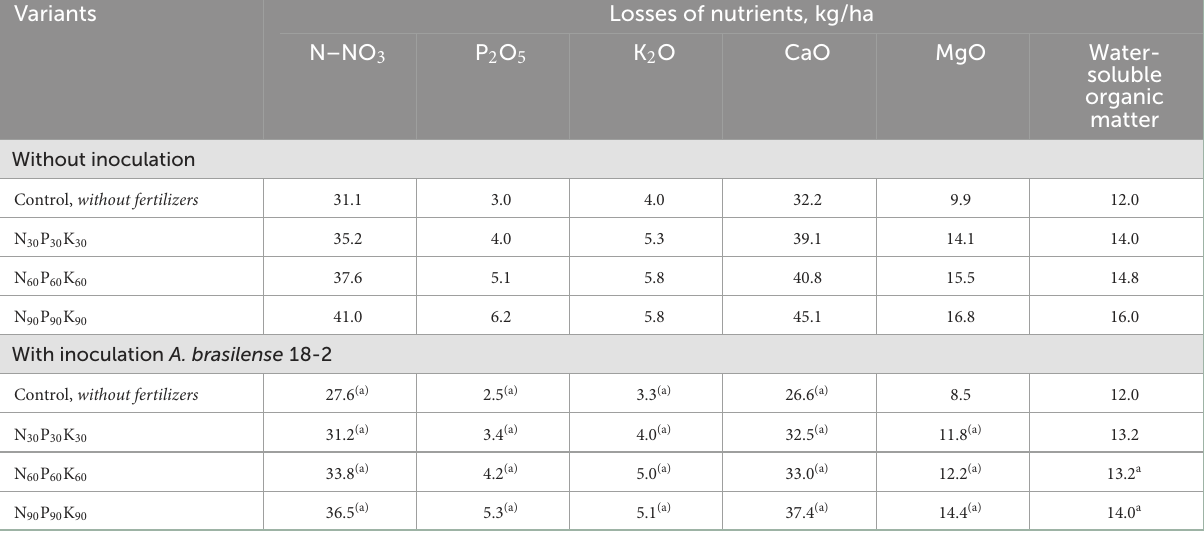
TABLE 6 The effect of fertilizers and pre-sowing winter rye seeds inoculation with A. brasilense 18-2 on losses of nutrients and water-soluble organic matter with drainage waters (March–July 2020) .